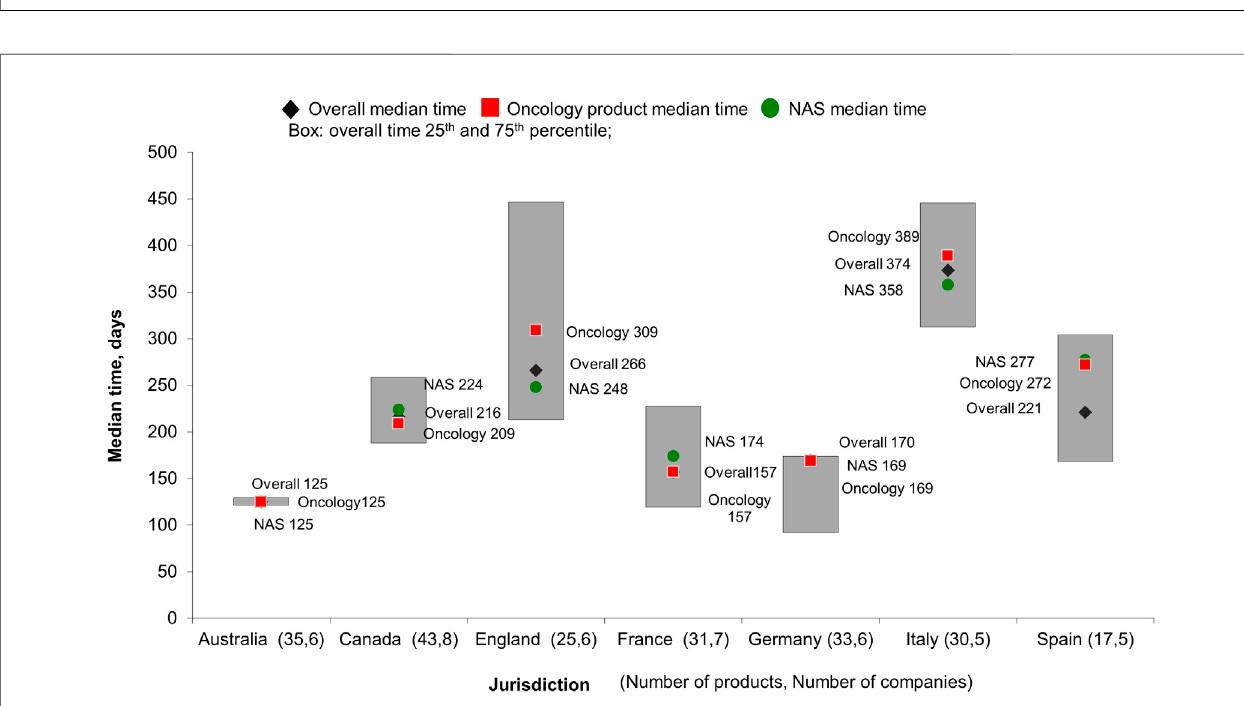
FIGURE 3 | HTA review time for products provided by participating companies.